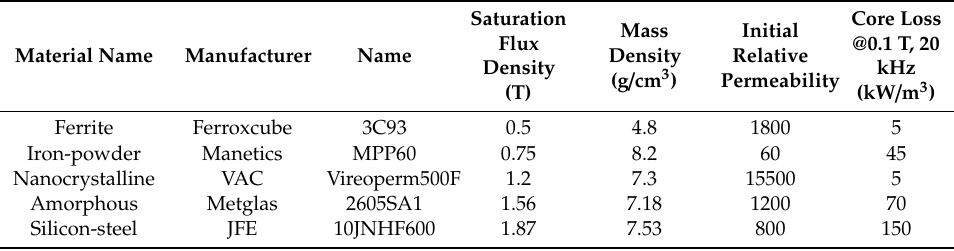
Table A2. Comparison of di ff erent magnetic